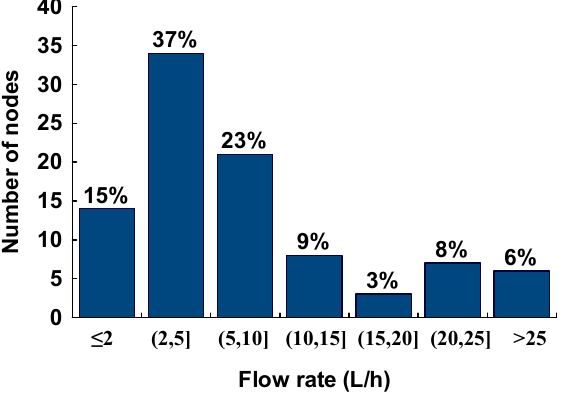
Figure 3. Distribution of nodal intrusion flow rates through 93 leak openings under the simulated pressure-deficient conditions.